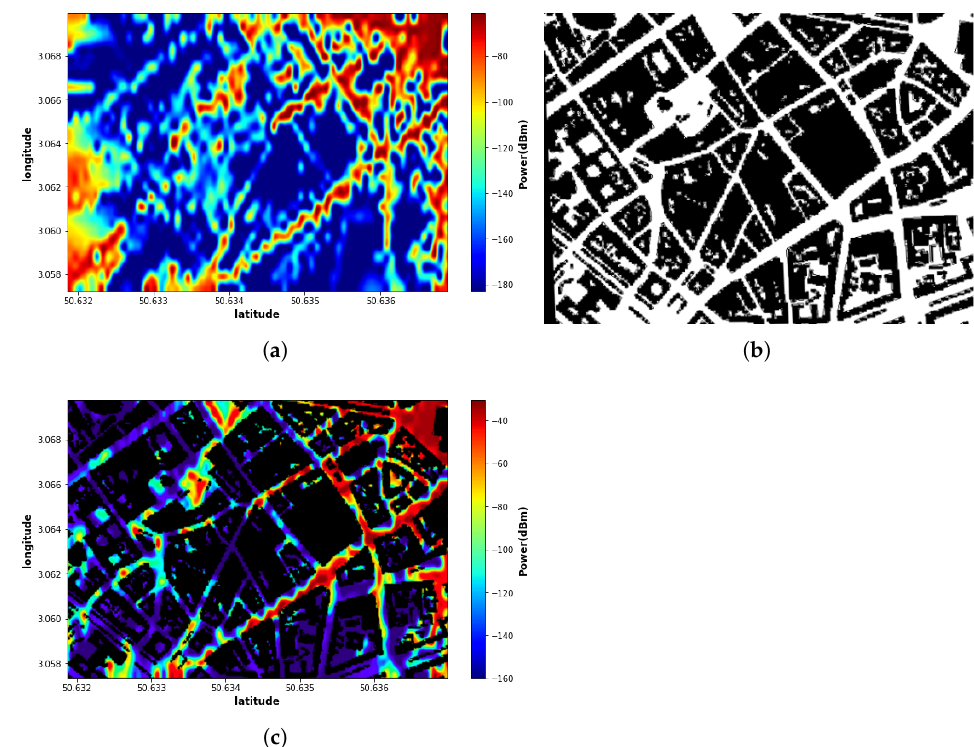
Figure 4. RF-EMF exposure reference map: ( a ) Reference map; ( b ) City topology; ( c ) Map superim- posed on city